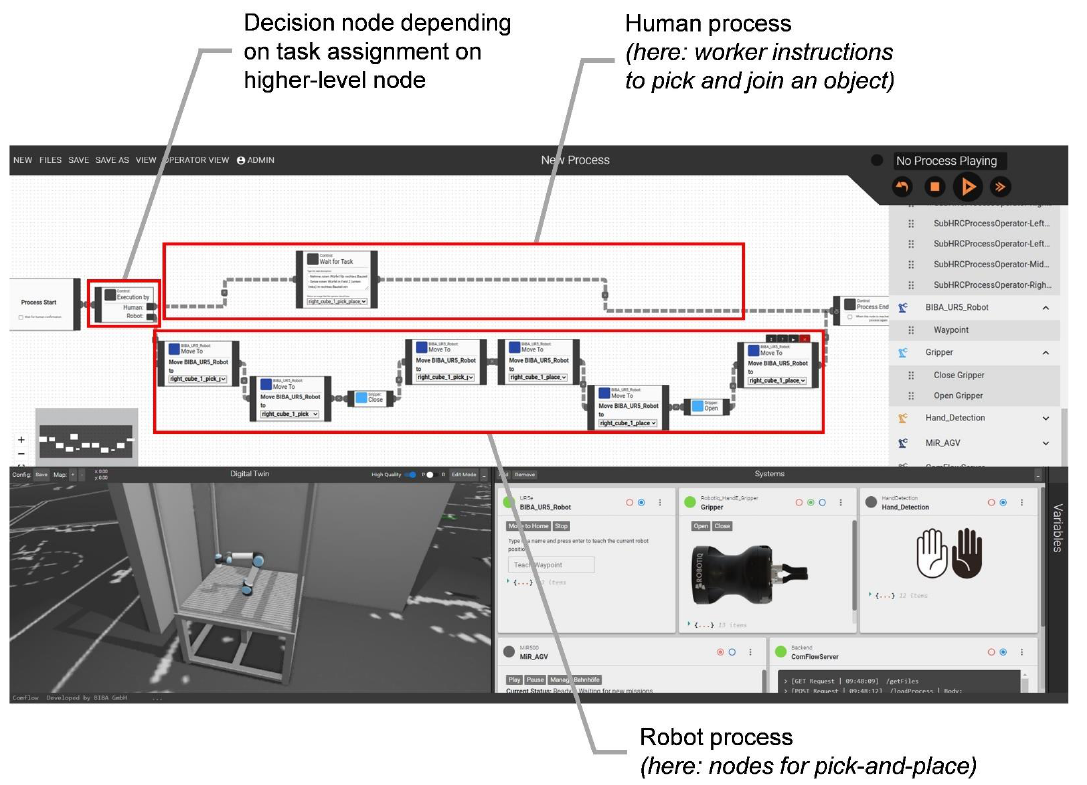
Figure 8. Implementation of sub-processes and HRC nodes in user interface: creation of the sub- process with sequences for both human and robot.